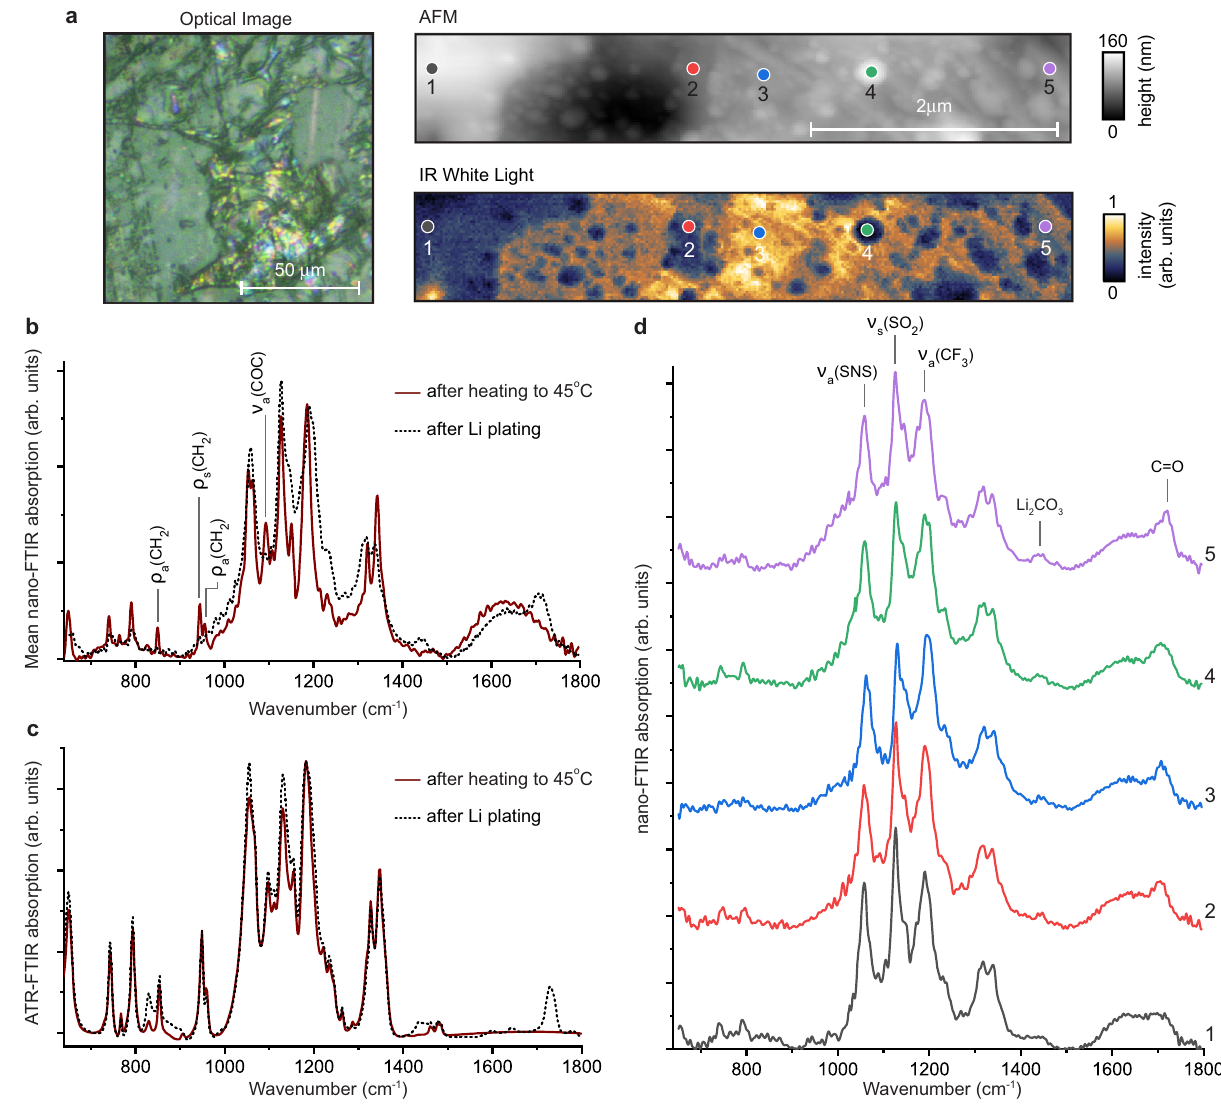
Fig. 3 Characterization of the G/Li/SEI/SPE interface after Li plating. a Optical, infrared (IR) white light, and atomic force microscopy (AFM) images after Li plating. b Averaged nano-FTIR and c ATR-FTIR spectra of the interface before Li plating (the after heating to 45 °C state) and after Li plating. d Local nano-FTIR spectra after Li plating (collection locations marked in AFM and WL